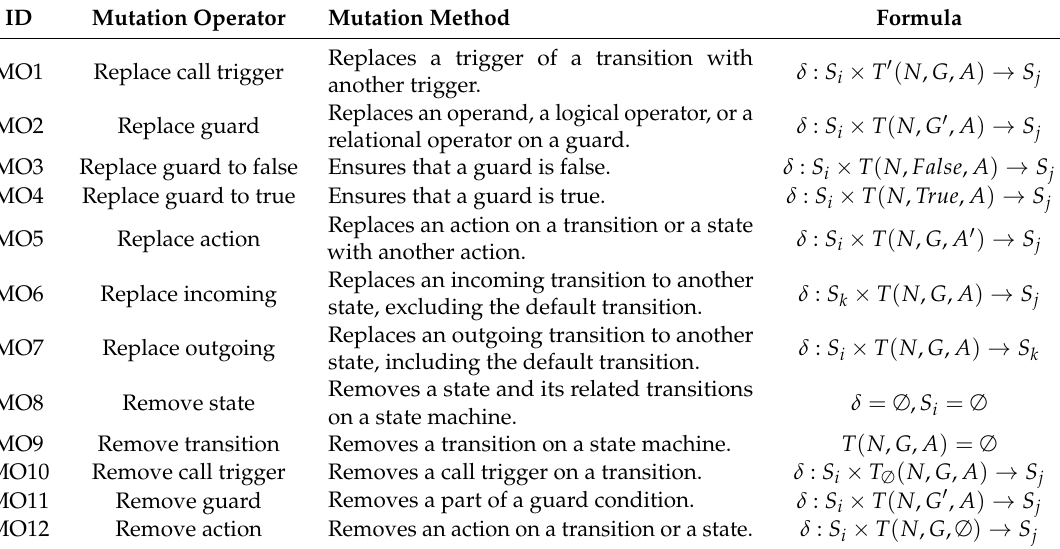
Table 1. Mutation Operators for State-Chart-Based Mutation